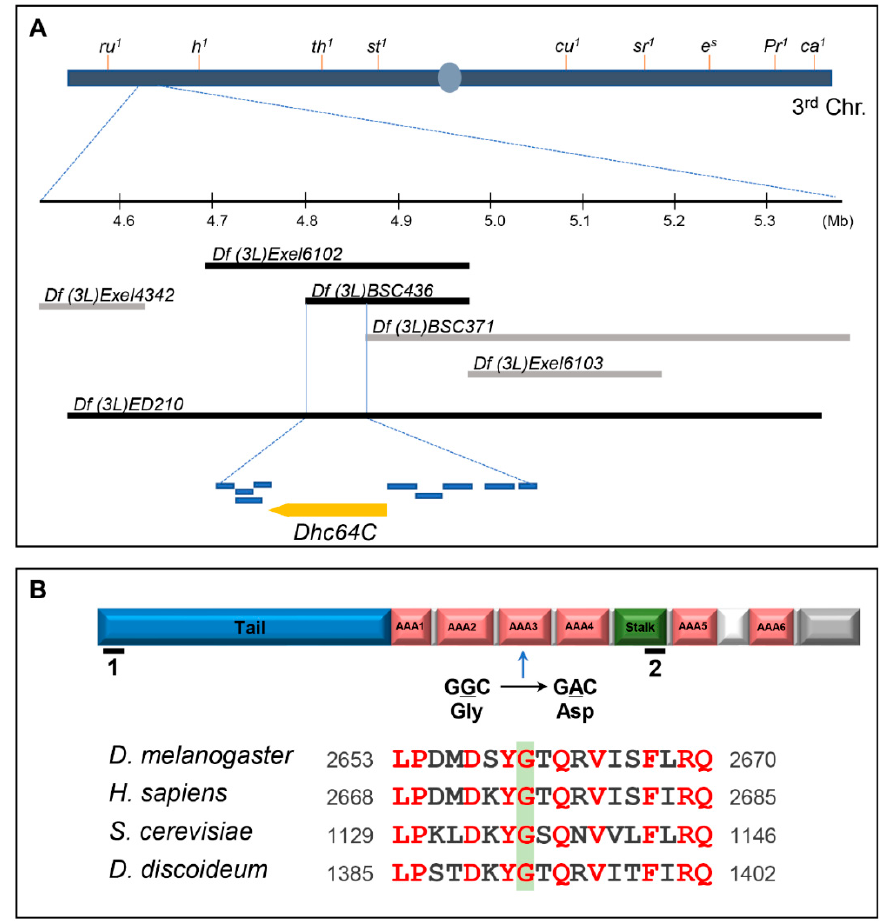
Figure 1. The lethal site in the sona suppressor m115 is mapped to the Dhc64C gene. ( A ) Mapping of the lethal site in m115 by meiotic and deficiency mapping. Meiotic mapping localized the lethal site in m115 between ru and h , which is further explained in Table S1. Multiple deficiencies were used to narrow it down to 64B17-64C1. Deleted range in the two deficiencies that uncover the lethal site of m115 are marked with black bars. Other deficiencies are marked with gray bars. Dhc64C and nine genes in the region common in the two deficiencies are presented as yellow and blue bars, respectively. Their names are listed in Table S2. ( B ) The domain structure of Dynein heavy chain. A point mutation from G to A results in one amino acid change from glycine (G) to aspartic acid (D) in the AAA3 domain of Dhc64C m115 . The region including the mutated site of Dhc64C m115 is conserved in Dhc proteins of model organisms. Red letters indicate amino acid residues conserved in these organisms. RNAi target site for BL28749 and NIG7507R-2 are marked by black lines with number 1 and 2,